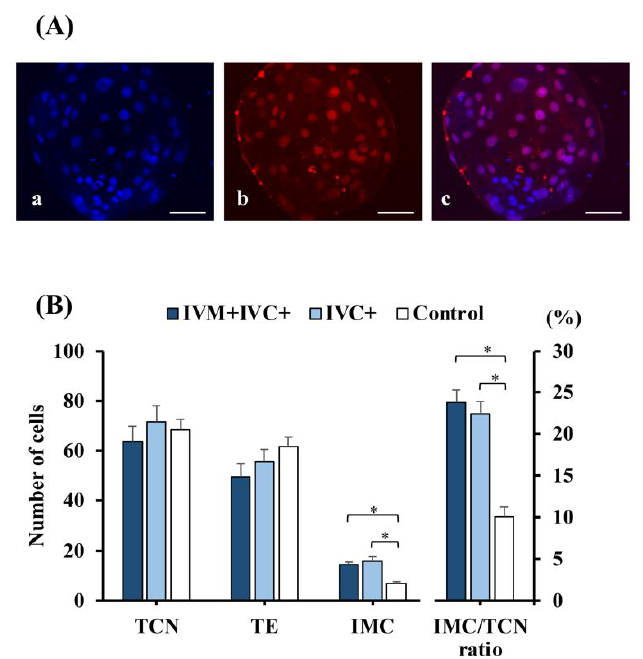
Figure 3. Effects of melatonin (1 nM) supplementation of in vitro maturation (IVM) and/or in vitro embryo culture (IVC) medium on the development of porcine zygotes. IVM + IVC+: melatonin added to both IVM and IVC media ( n = 410); IVC+: melatonin added only to the IVC medium ( n = 406); control: untreated ( n = 409). The number of blastocysts evaluated to determine the total cell number in each group was 97, 105, and 93, respectively. Cleavage: percentage of oocytes insemi- nated that developed to the 2- to 4-cell embryos at 48 h of culture; blastocyst formation: percentage of cleaved embryos that progressed to blastocyst at day 7 of culture; blastocyst efficiency: percentage of oocytes inseminated that progressed to blastocysts. * p < 0.006. Data are presented as the means ± SEM of six replicates.